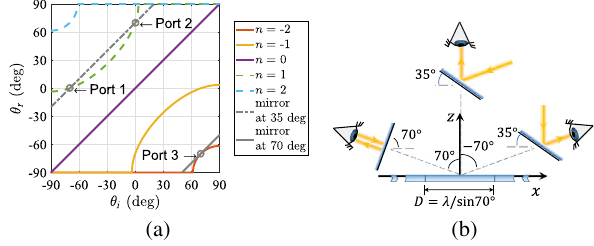
FIG. 3. (a) Operation of the anomalous reflector proposed in Ref. [23]. Reflection angle versus incident angle for different Floquet harmonics. All the harmonics are considered. The circles show at what angle θ r all the incident energy is reflected from the considered anomalous reflector when it is excited from the corresponding port. (b) The flat anomalous reflector appears to an external observer at different angles as differently tilted mirrors. At θ i ¼ 0 ° and θ i ¼ − 70 ° angles, it appears as a mirror tilted at 35°. However, at a θ i ¼ 70 ° angle, the observer would see himself as in a mirror tilted at n ¼ þ 1 . The grey dashed line denotes the specular reflec- tion angles for an equivalent mirror tilted at θ i = 2 ¼ 35 ° (for such a mirror, θ r ¼ θ i þ 70 °). As is expected, the reflector imitates the behavior of a tilted mirror at two angles, when θ − 70 ° (marked by circles in the plot). i equals 0° and